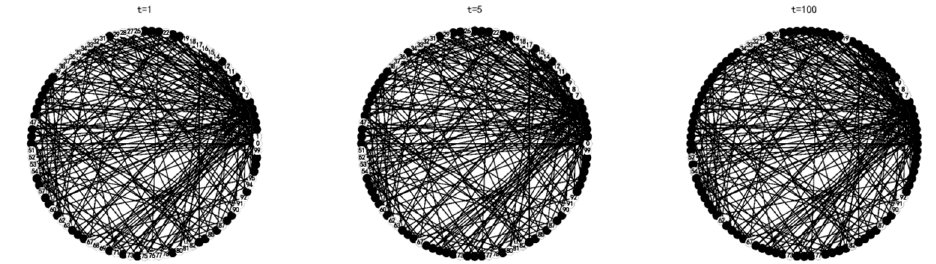
Figure 5. The status of the group at t = 1, t = 5, t = 100.